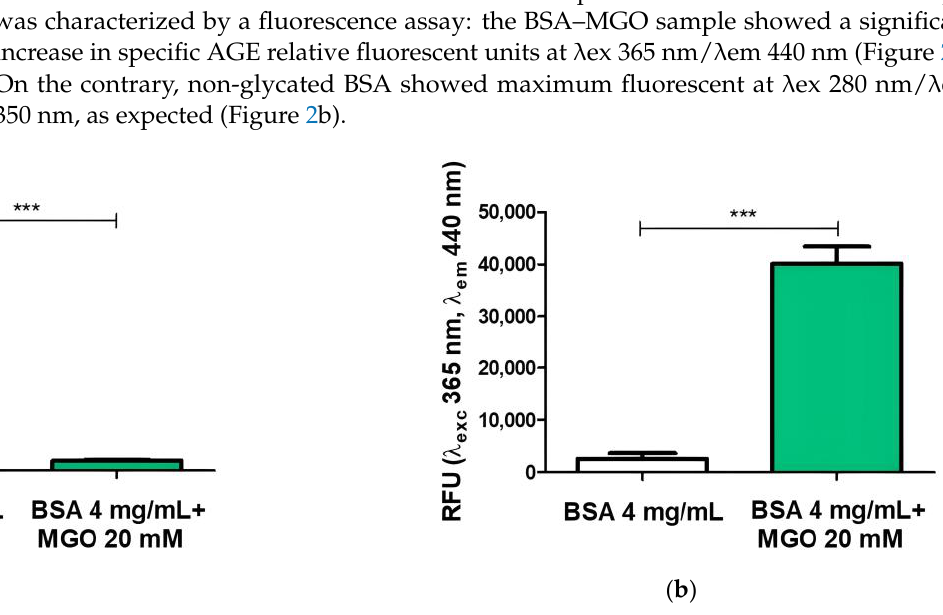
Figure 2. Fluorescence measurement of AGEs after 168 h of incubation. Data represent relative fluorescence units (RFU) at ( a ) λ ex 365 nm/ λ em 440 nm and ( b ) λ ex 280 nm/ λ em 350 nm for BSA non-glycated (BSA) and BSA glycated (BSA + MGO). The analysis of variance was carried out using t -test analysis; *** p < 0.001 value was considered significant (BSA vs. BSA-MGO). All values are expressed as M ± SD (n =